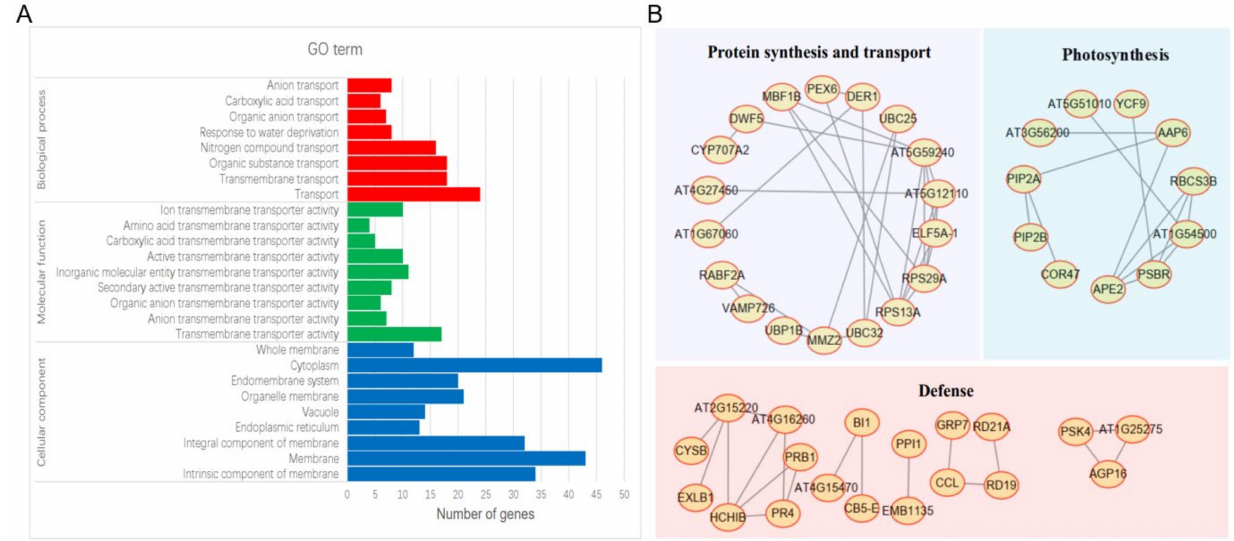
Figure 4. Analysis of homologues of 6K1 interactors in A. thaliana using STRING database. Gene Ontology (GO) analysis ( A ) and protein–protein interaction networks ( B ) of homologues of 6K1 interactors in A. thaliana